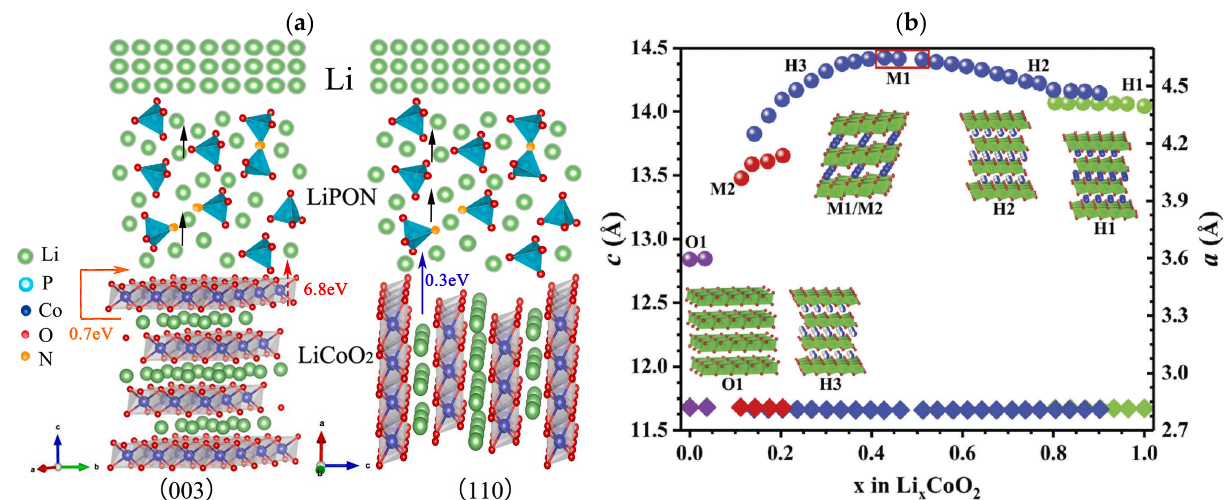
Figure 2. ( a ) Scheme of LCO(003)/LiPON/Li and LCO(110)/LiPON/Li thin-film lithium batteries. Reproduced with permission [48]. Copyright 2022, Elsevier. ( b ) Variations in the a and c parameters and phases during Li-ion extraction from LCO electrodes. Reproduced with permission [52]. Copyright 2018, Royal Society of Chemistry.